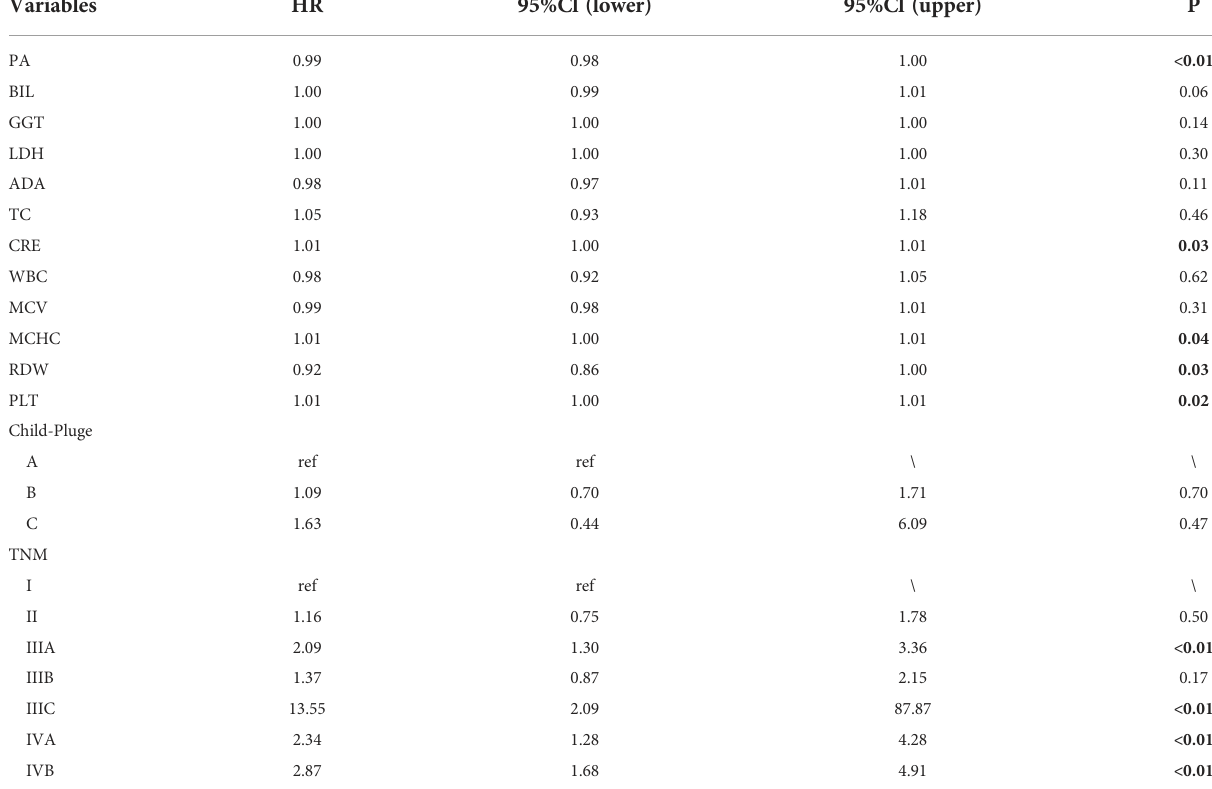
TABLE 2 Multivariate Cox regression analyses of variables.